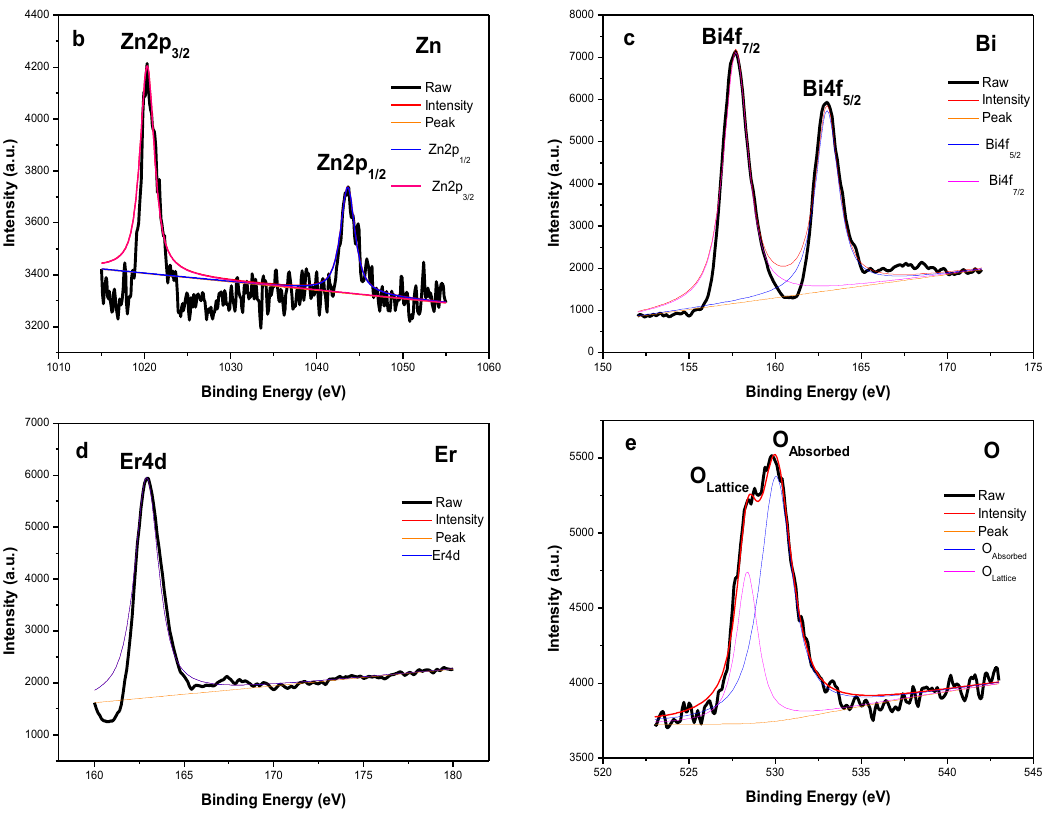
Figure 8. ( a ) The XPS full spectrum of ZnBiErO 4 ; ( b ) Zn2p spectrum of ZnBiErO 4 ; ( c ) Bi4f spectrum of ZnBiErO 4 ; ( d ) Er4d spectrum of ZnBiErO 4 ; ( e ) O1s spectrum of ZnBiErO 4 . The UV-vis absorption spectra of ZnBiErO 4 and N-doped TiO 2 are shown in Figure 9. In contrast to the N-doped TiO 2 , whose absorption edge was 414 nm, the novel synthesized ZnBiErO 4 photocatalyst exhibited an obvious absorption in the visible region up to 690 nm. Furthermore, the band gap of ZnBiErO 4 and N-doped TiO 2 by extrapolating the linear portion of the curve to zero absorbance are 1.69 eV and 2.76 eV, respectively. It indicated that ZnBiErO 4 could be excited by visible light and might exhibit a better visible light photocatalytic activity. Apparently, reflection and scattering did not cause a significant absorption.